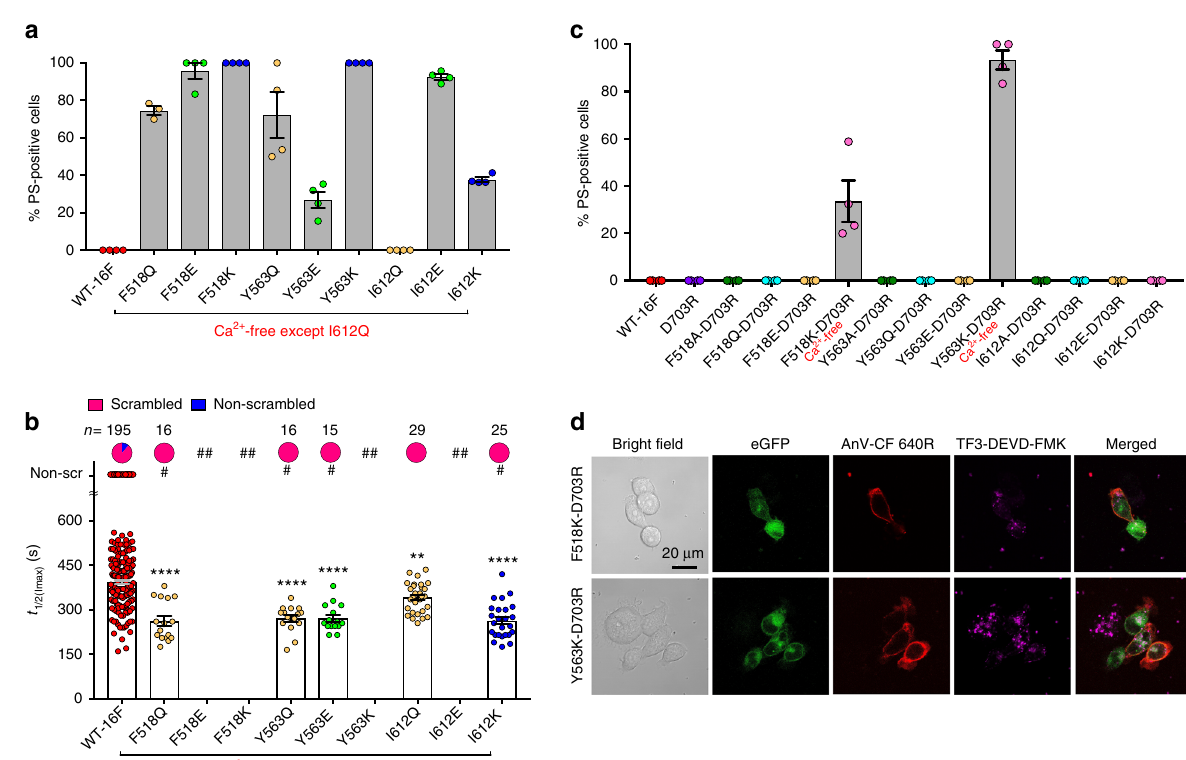
Fig. 5 Hydrophilic or charged mutations at the inner gate make TMEM16F constitutively open. a Except I612Q, all inner gate mutations with polar and charged side chains were constitutively active with spontaneous CaPLSase activities. Each dot represents the percentage of PS-positive cells over the total expressing cells (either WT-TMEM16F or mutants) in one coverslip (see Methods for details). Except I612Q, all other TMEM16F mutants were expressed in Ca 2 + -free medium to suppress their excessive scrambling activity and cytotoxicity. b Ionomycin-induced CaPLSase activity for wild type (WT) and the mutant TMEM16F quanti fi ed by t 1/2(Imax) . The constitutively activated TMEM16F mutants that caused >80% of spontaneous PS exposure (##) were excluded from this analysis. For the modest gain-of-function mutations (<80% spontaneous PS exposure, #), only the cells that did not show spontaneous PS exposure were analyzed for their t 1/2(Imax) values after ionomycin stimulation. Each dot represents one cell, and n is the total number of cells measured. The pie charts illustrate the percentages of ionomycin-induced scrambling cells, and non-scr denotes non-scrambling. Statistical analysis was performed using one-way ANOVA with Tukey ’ s multiple comparisons test. **: p = 0.0093; ****: p < 0.0001. Error bars indicate SEM. c The impaired Ca 2 + binding site mutation D703R suppressed all constitutively activated TMEM16F CaPLSases except F518K and Y563K. Each dot represents the percentage of PS-positive cells over the total expressing cells in one coverslip. d Representative images of eGFP-tagged F518K-D703R- and Y563K-D703R-expressing in TMEM16F- knockout HEK293T cells in the absence of ionomycin stimulation. AnV-CF 640 R labeled PS-positive cells. Weak TF3-DEVD-FMK staining of cleaved caspases 3/7 suggests that the cells are not apoptotic. Both F518K-D703R and Y563K-D703R (in c and d ) were expressed in Ca 2 + -free medium to avoid cell death and cytotoxicity, while all other D703R-coupled mutations (in c ) were expressed in normal Ca 2 + medium. All experiments were done in the TMEM16F-knockout HEK293T cells. All of the experiments based on AnV labeling were done in Ca 2 + -containing buffer. Scale bar, 20 µ m. Source data